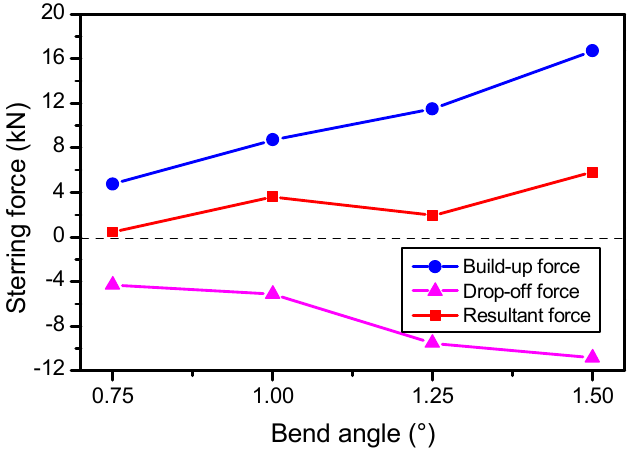
Figure 16. Steering force versus the positive displacement motor (PDM) bend angle.